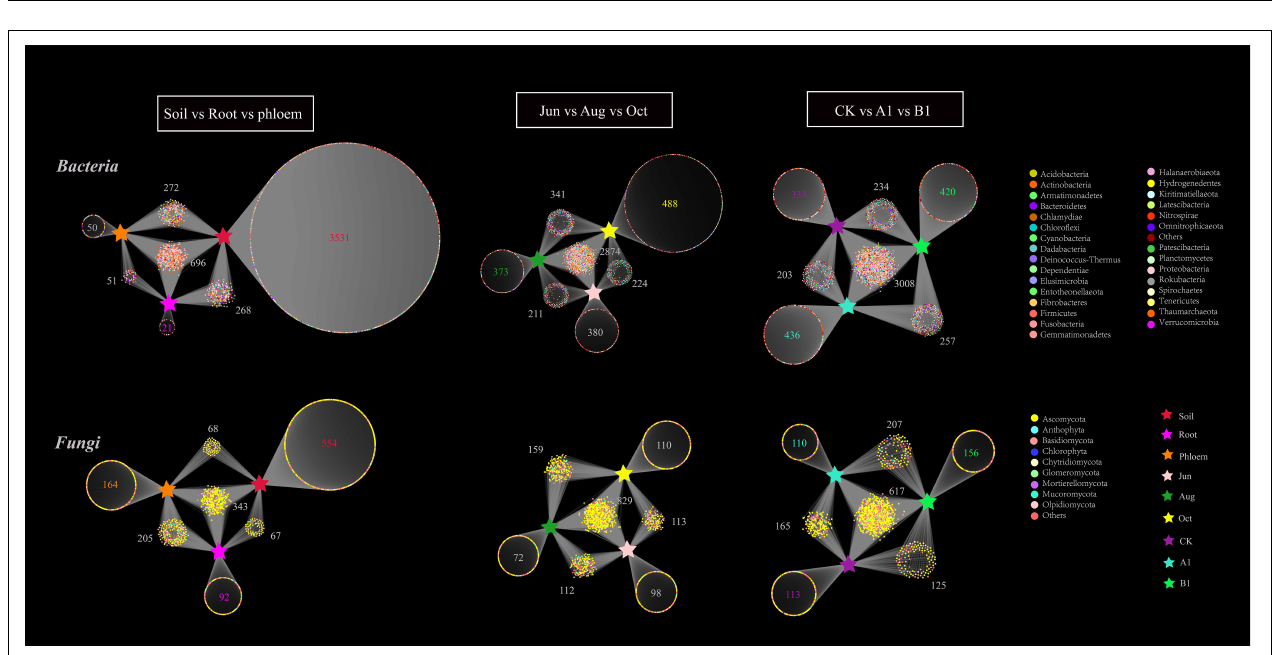
FIGURE 5 | Bacterial and fungal community composition analysis. (A) Phyla/class distribution for both bacterial and fungal communities across the three habitat classifications (soil, roots, and stems), seasons (June, August, and October), and genotypes (CK, A1, and B1). (B) Average relative abundance (%) of bacterial phyla and fungi classes in soil, roots, and phloem for different seasons in CK, A1, and B1. The total relative abundances and significant effects of all phyla of bacteria and classes of fungi are listed in Supplementary Tables 4, 5 .